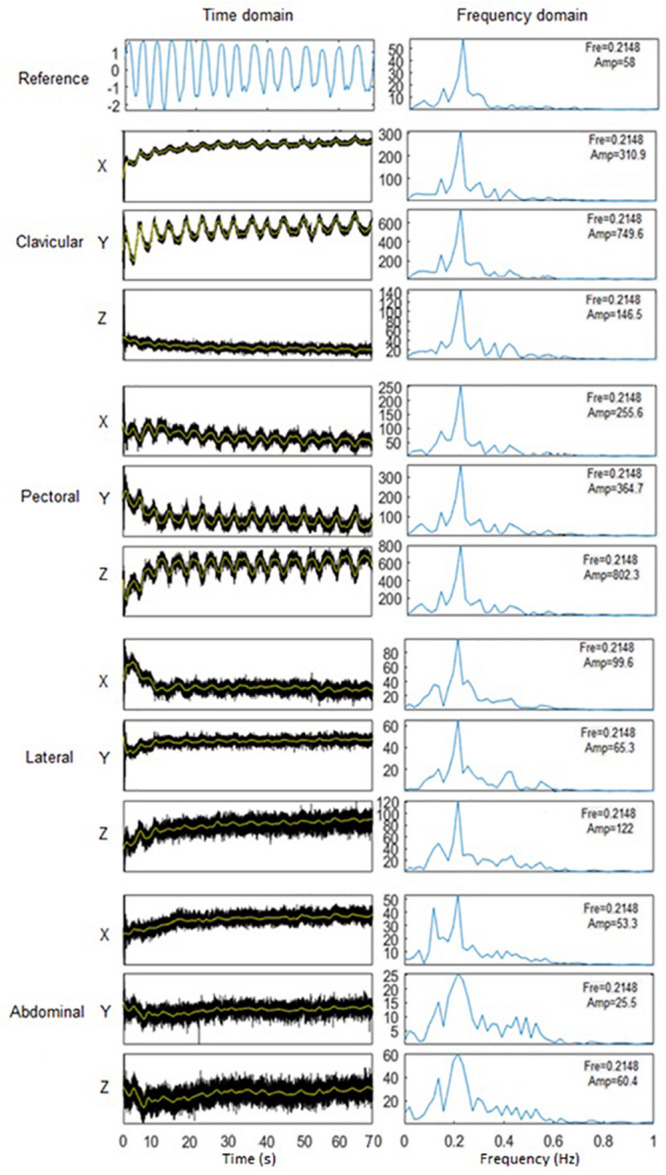
Extraction of respiratory frequency (RF) in Matlab. Left: waveform of processed respiratory signals in time domain. Signals in 3 directions in 4 sites were juxtaposed to give an indication of signal quality. Right: signal intensity spectra in frequency domain. RF was estimated by as the peak frequency (Fre), with the amplitude (Amp) of signal intensity marked.